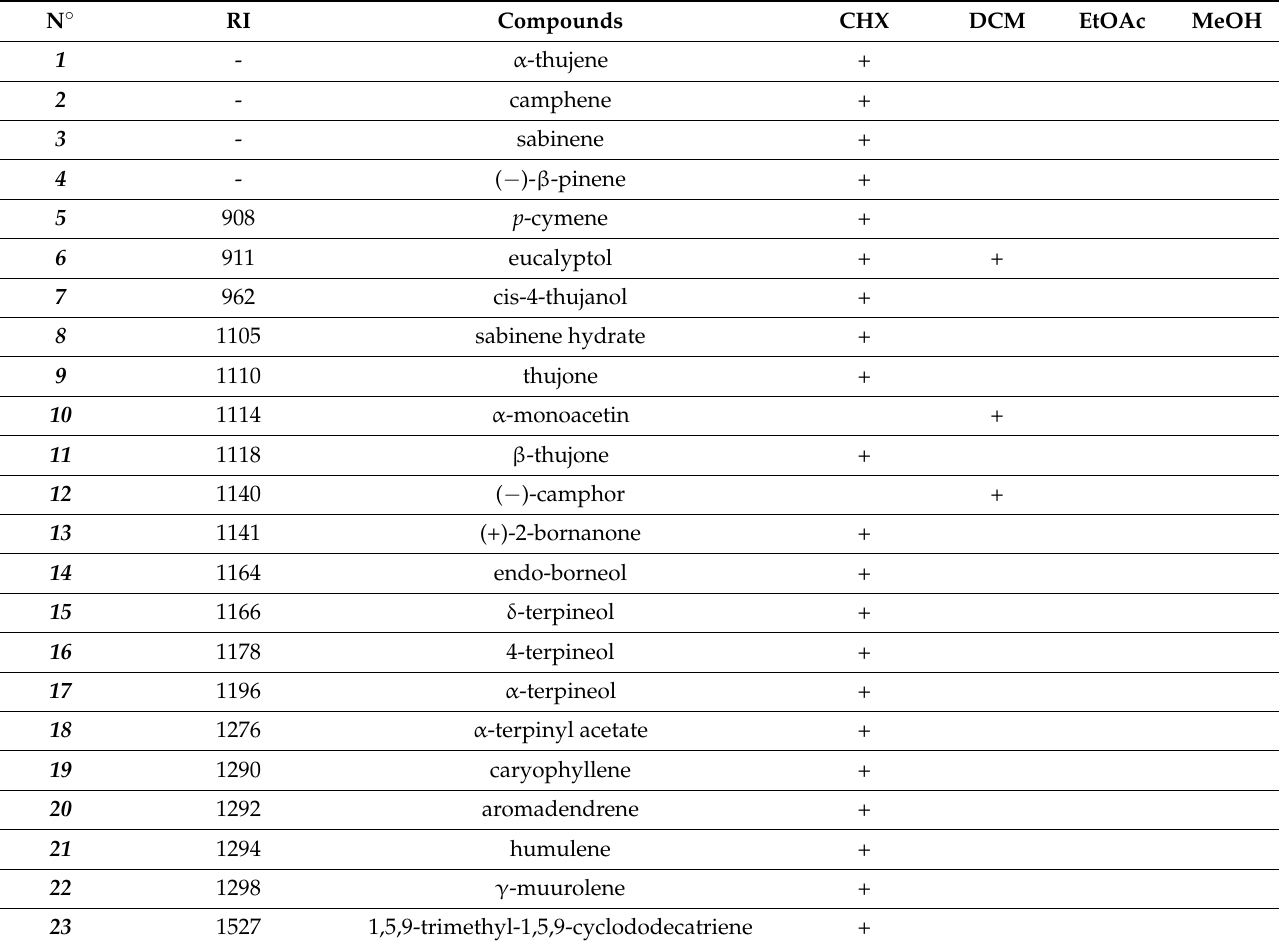
Table 2. Compounds detected by GC-MS in the four extracts of S. fruticosa before and after derivati- zation